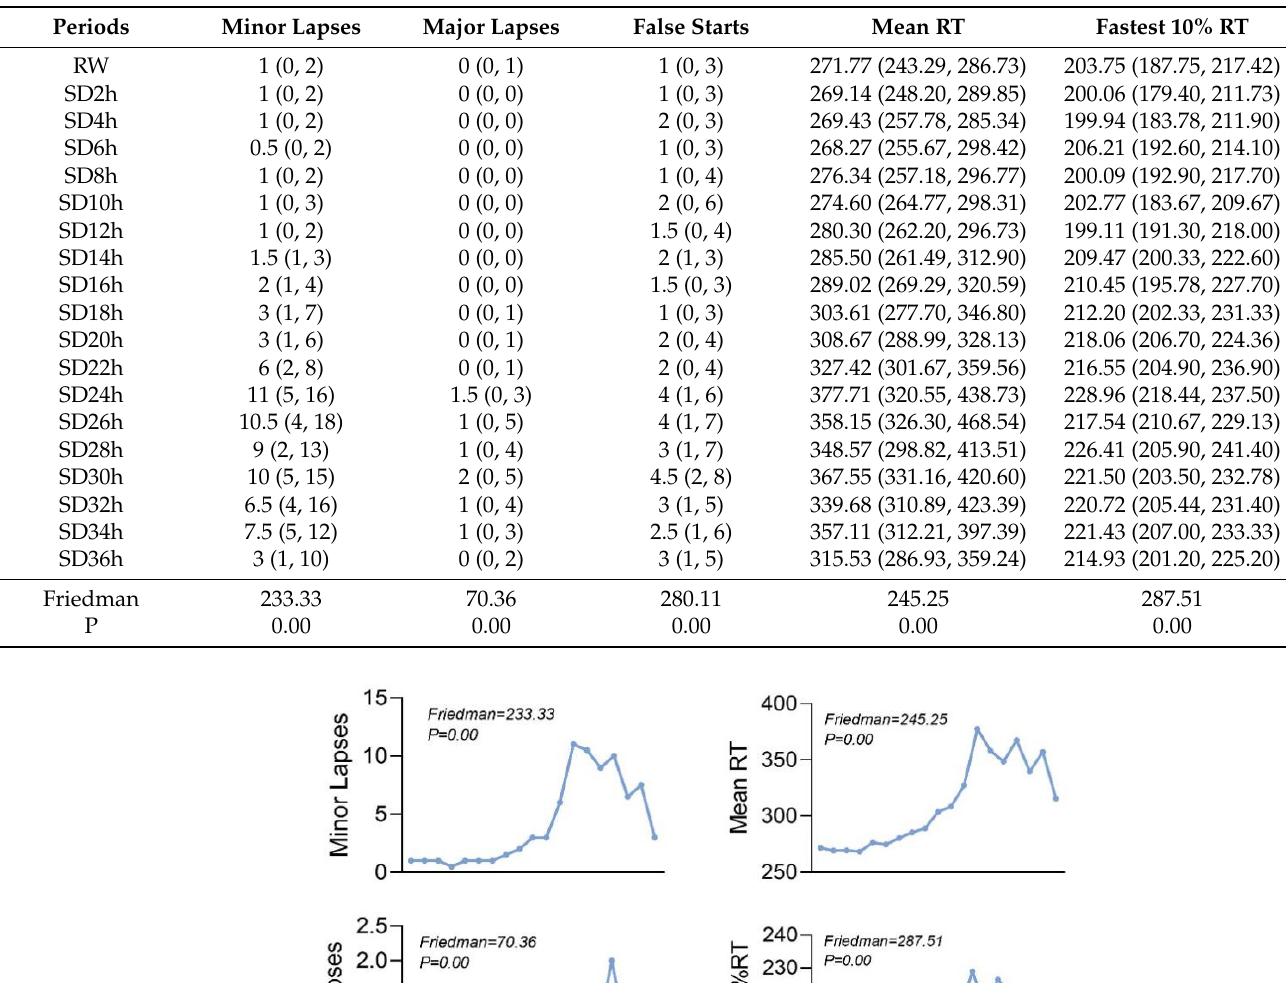
Table 1. PVT performance at 19 points during the acute sleep deprivation period.